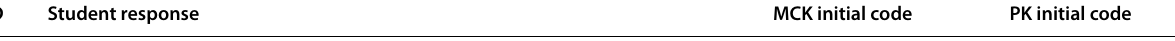
Table 7 Individual coding with support